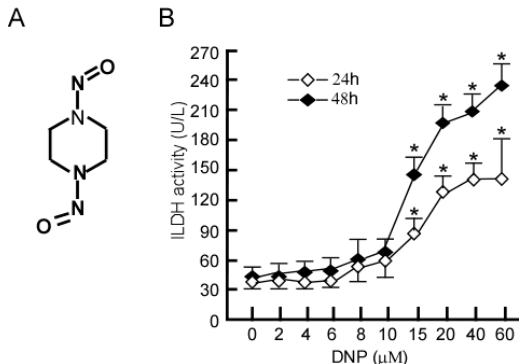
( A ) Structure of DNP, an N -nitroso compound; ( B ) 6-10B cells were treated with 2, 4, 6, 8, 10, 15, 20, 40, or 60 μ M DNP for 48 h, and then LDH activity in the cell culture